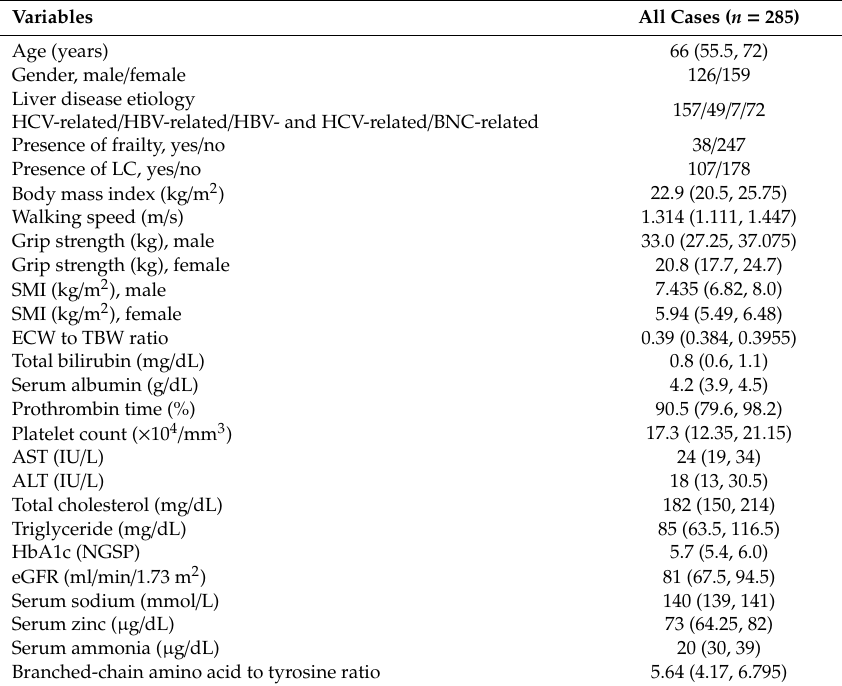
Table 1. Baseline characteristics ( n =